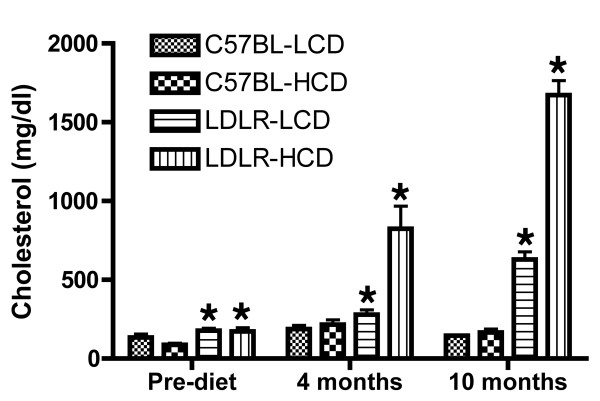
Plasma cholesterol levels in C57BL6/J and LDLR-/- mice fed low- or high-cholesterol diets. Two-month old C57BL/6J wild type (C57BL) or LDLR-/-mice were fed either low (LCD) or high (HCD) cholesterol diets for 4 or 10 months. Plasma cholesterol was determined at baseline (Pre-diet, n = 11/group), as well as after 4 (n = 11/group; except n = 12, LDLR-HCD) or 10 (n = 6, C57BL-LCD; n = 6, C57BL-HCD; n = 5, LDLR-LCD; and n = 2, LDLR-HCD) months. Asterisks indicate groups different from C57BL-LCD at each time point (p < 0.05). Results are discussed further in the text.